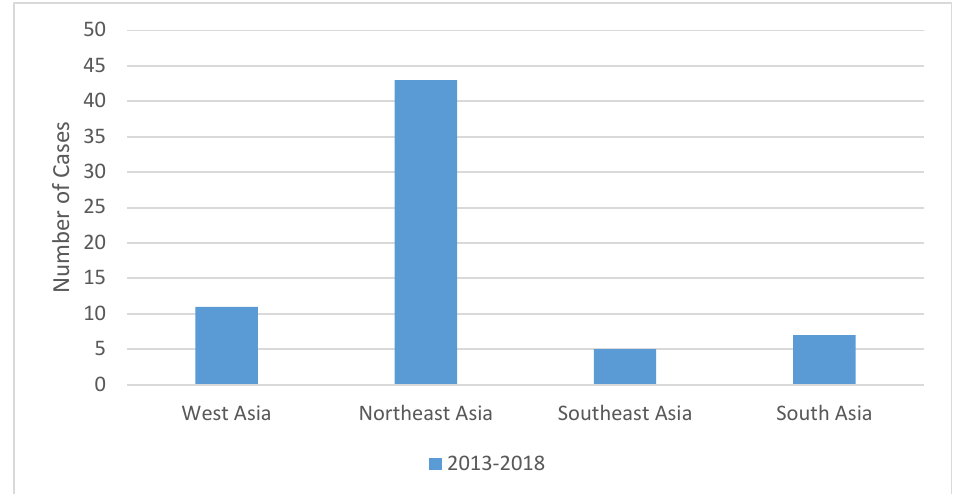
Figure 1. Number of Monitored Cases of Missing, Illicit Trafficking, or Theft of Radioactive Materials in Asia from 2013 to 2018